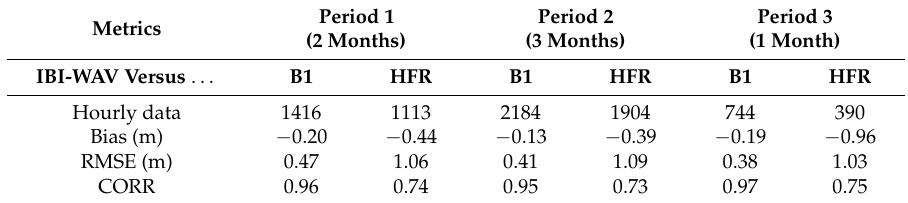
Table 1. Skill metrics derived from the intercomparison of modeled wave height data (IBI-WAV) against in situ (B1 buoy) and remote sensed high-frequency radar (HFR) data for three selected wintertime